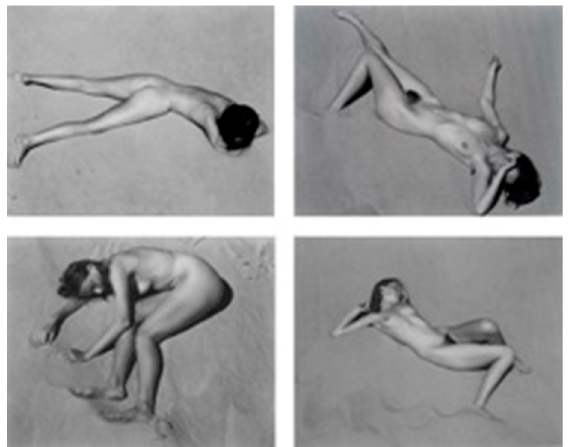
Figure 12. Edward Weston, Nude on Sand (1936), © courtesy of private collection.